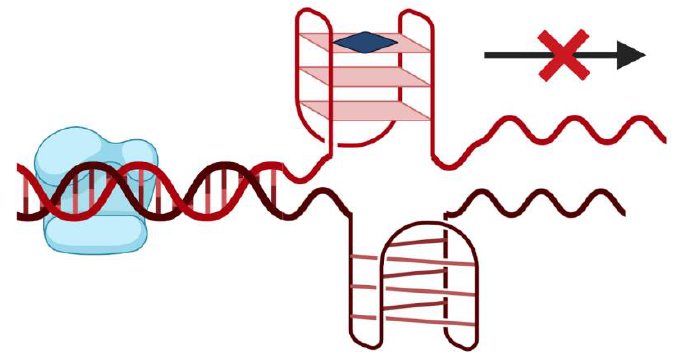
Figure 2. Small molecule (represented by the blue square) driven stabilization of promoter G4s and transcriptional regulation.